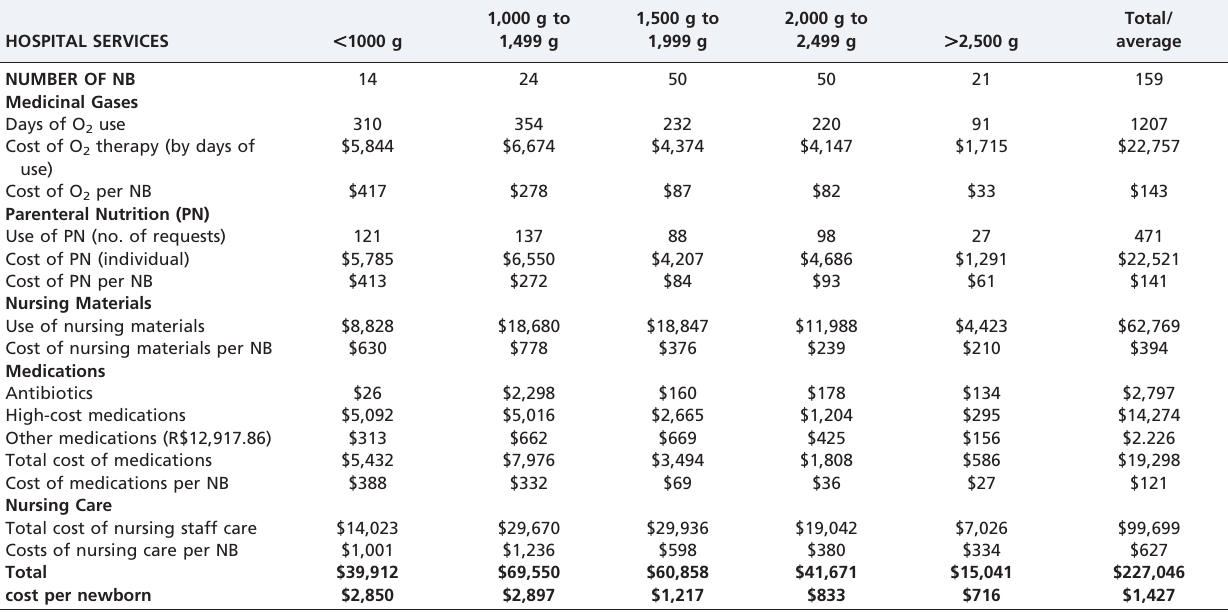
Table 1 - Cost of hospital services for premature newborns by birth weight.